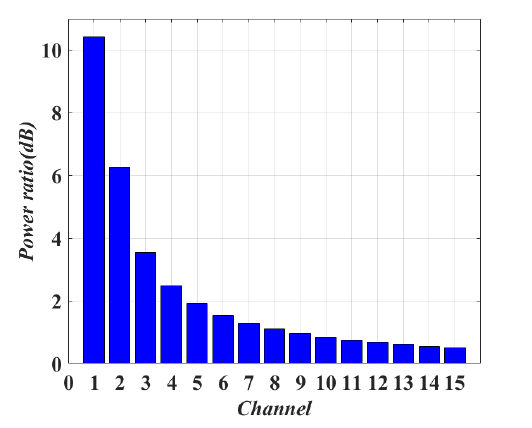
Figure 7. Optical power ratio results of each